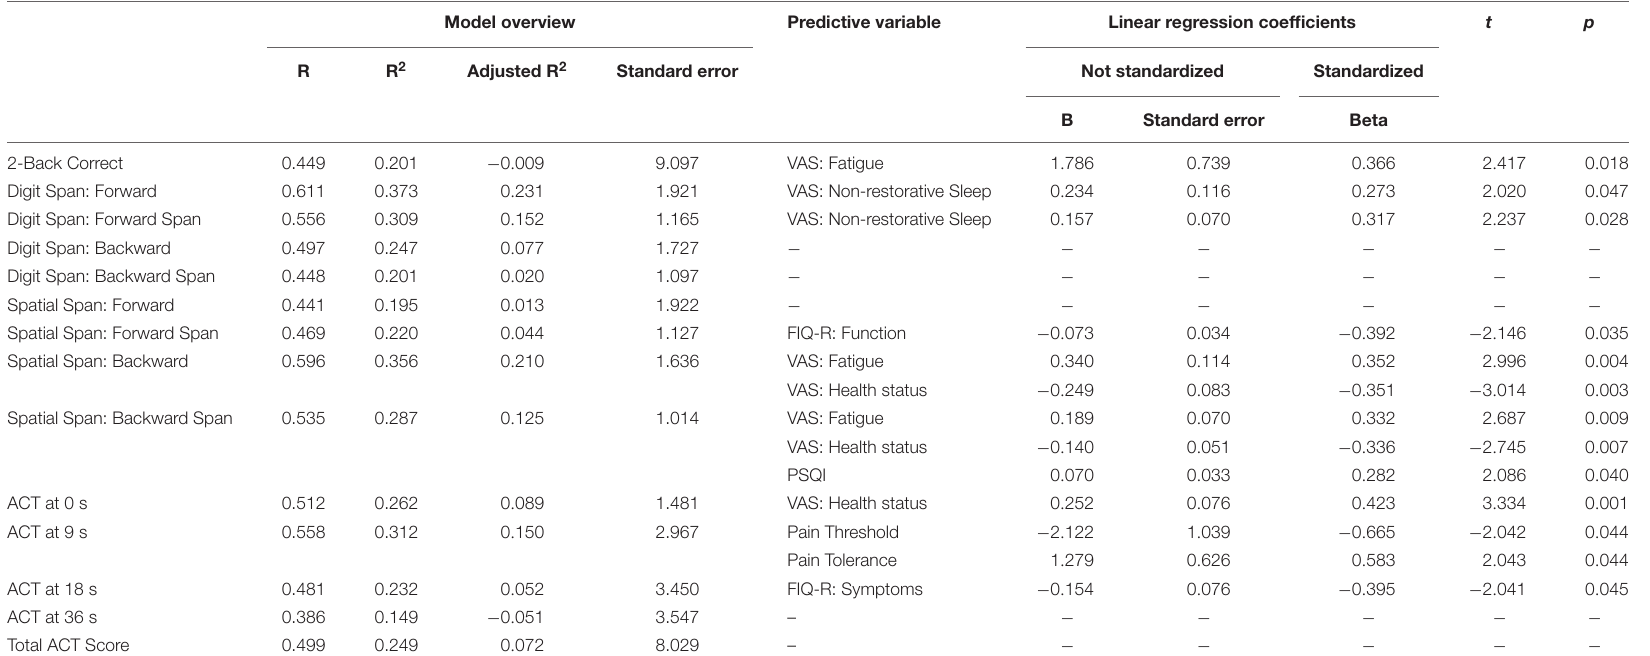
VAS, Visual Analogical Scale; FIQ-R, Fibromyalgia Impact Questionnaire; ACT, Auditory Consonant Trigram